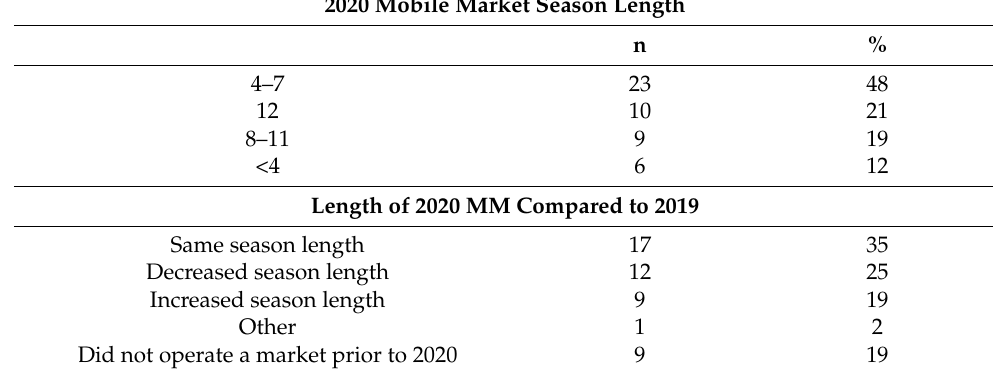
Table 3. Mobile Market Season Lengths.